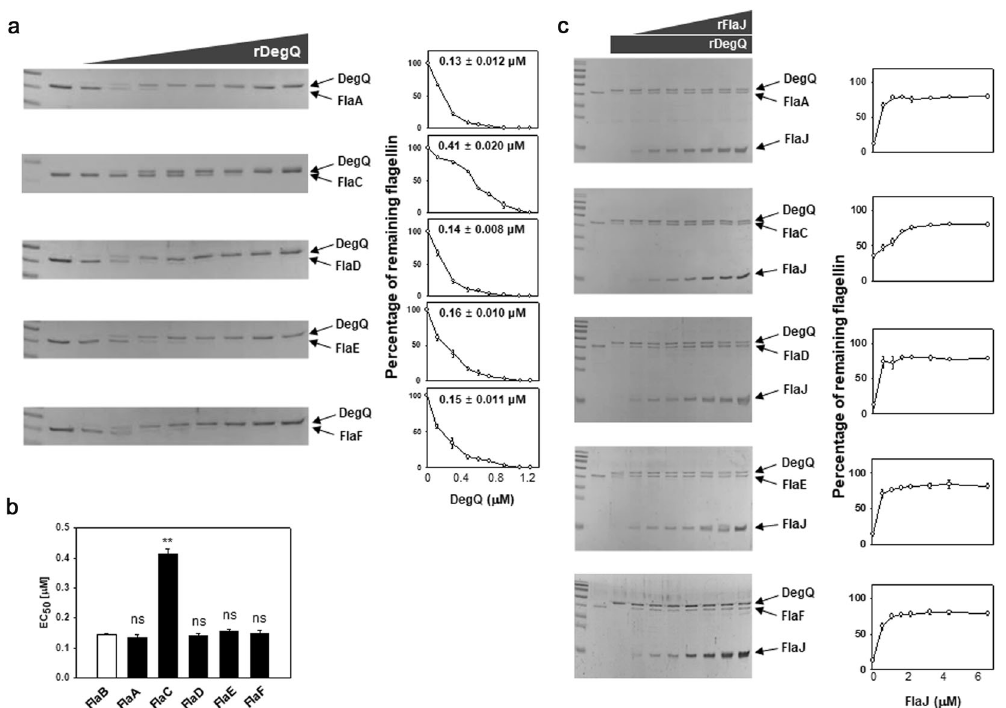
Fig. 6 In vitro proteolysis of FlaA, FlaC, FlaD, FlaE, and FlaF. a , b Proteolysis of fl agellins and fl agellin-homologous proteins (FHPs) by DegQ. Recombinant proteins (1 μ M each) of the fl agellins (rFlaA, rFlaC, and rFlaD) and FHPs (rFlaE and rFlaF) were incubated with various concentrations of rDegQ (0, 0.12, 0.3, 0.48, 0.6, 0.72, 0.9, 1.08, and 1.2 μ M). As described in Fig. 5, the remaining fl agellins in reaction mixtures were resolved in SDS-PAGE (the gel images in a ), and their relative amounts were plotted against the given concentrations of rDegQ with the calculated values of EC 50 (the graphs in a ). The average values of EC 50 for proteolysis of fl agellins by rDegQ were obtained from three independent assays ( b ). The error bars represent standard deviation. The P- values for comparison with the EC 50 for rFlaB (derived from Fig. 5d) were indicated (Student ’ s t -test; ** P < 0.005; ns, not signi fi cant). c Protection of fl agellins and FHPs from DegQ proteolysis by FlaJ. The proteolysis assays were performed using the same recombinant proteins in the reaction mixtures containing 1.08 μ M rDegQ and various concentrations (0, 0.56, 1.11, 1.67, 2.22, 3.34, 4.45, and 6.67 μ M) of rFlaJ. Flagellins in the reaction mixtures resolved in SDS-PAGE (the gel images in c ) were subjected to quantitative determination using densitometry. The relative intensities of fl agellin bands were plotted against the given concentrations of upstream regions. The genes of fl aA , fl aB , and fl aD were shown to have promoters highly homologous to the consensus RpoF ( σ 28 ) promoter that includes -10 (GCCGATAA) and -35 (CTAAAG) (Fig. 9c, d, and f). In contrast, a RpoN ( σ 54 )-dependent promoter, which